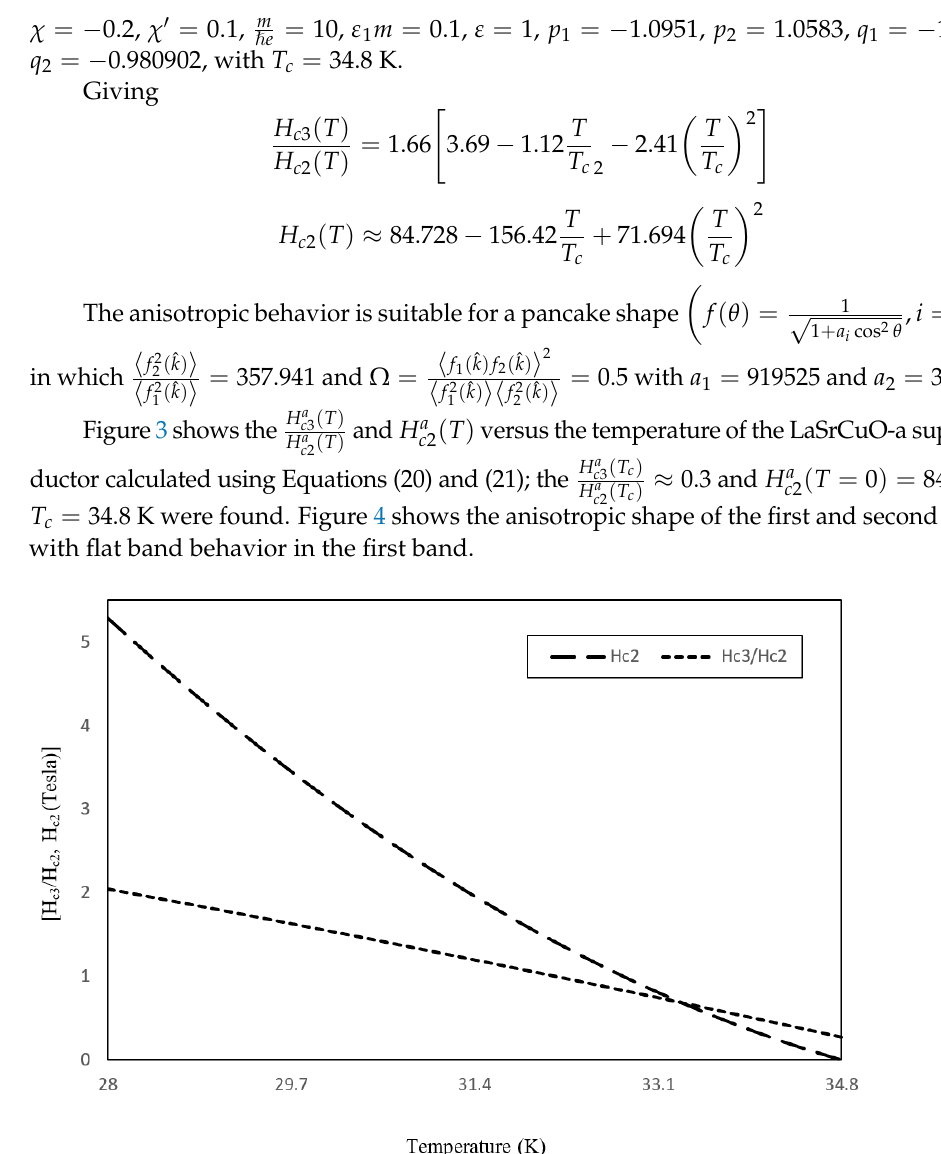
Figure 3. The tor. Figure 3. The H Figure 3. The and )( tor.